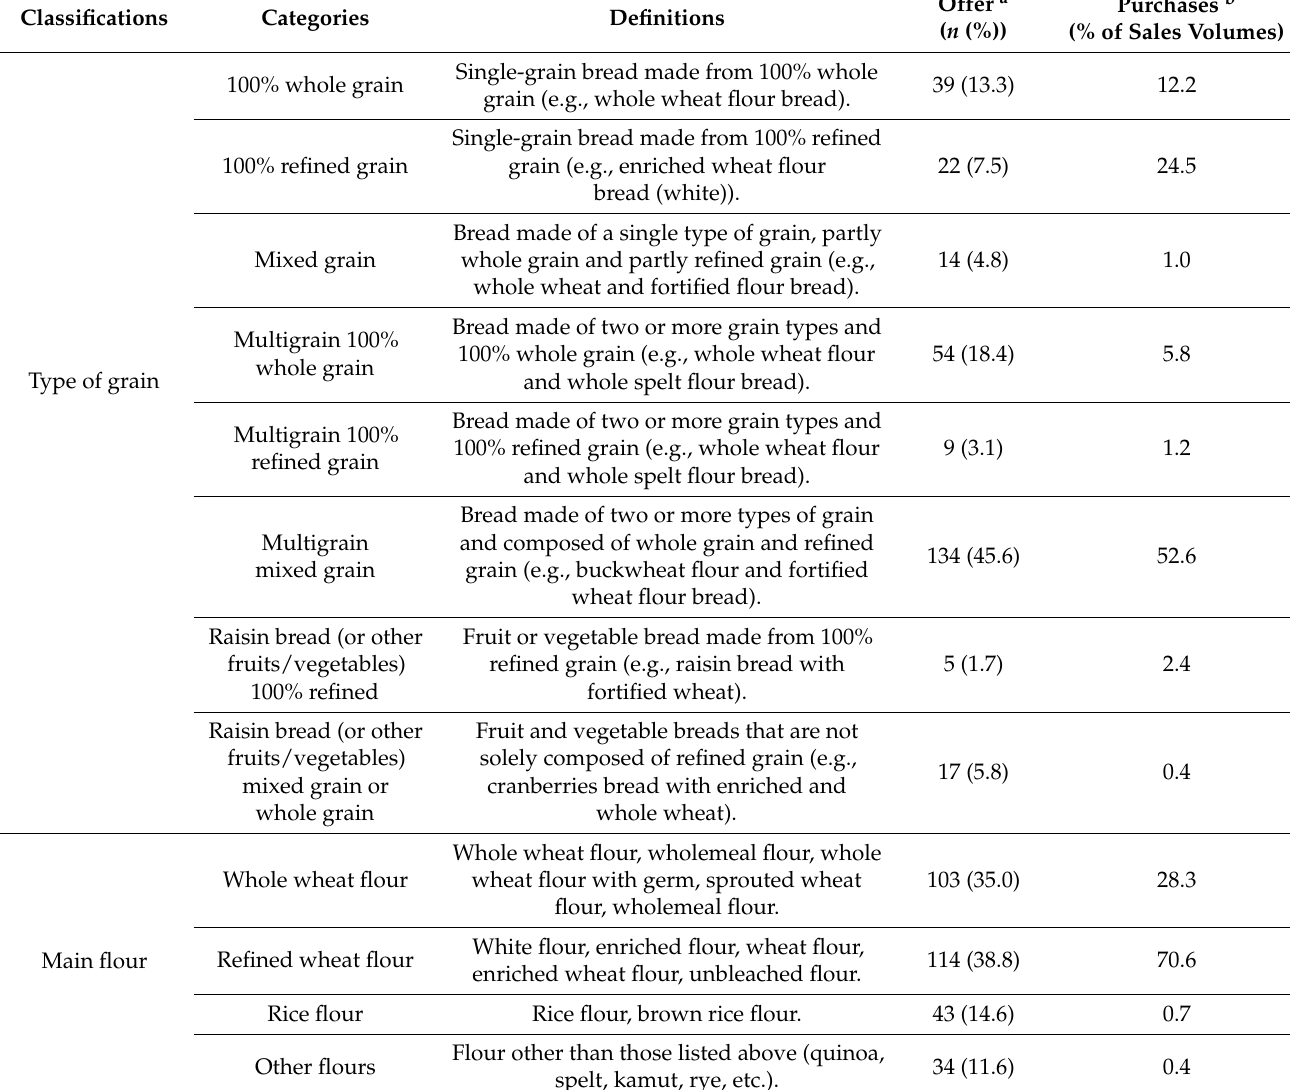
Table 1. Offer, purchases, and definitions of sliced bread according to their types of grain and main flour.